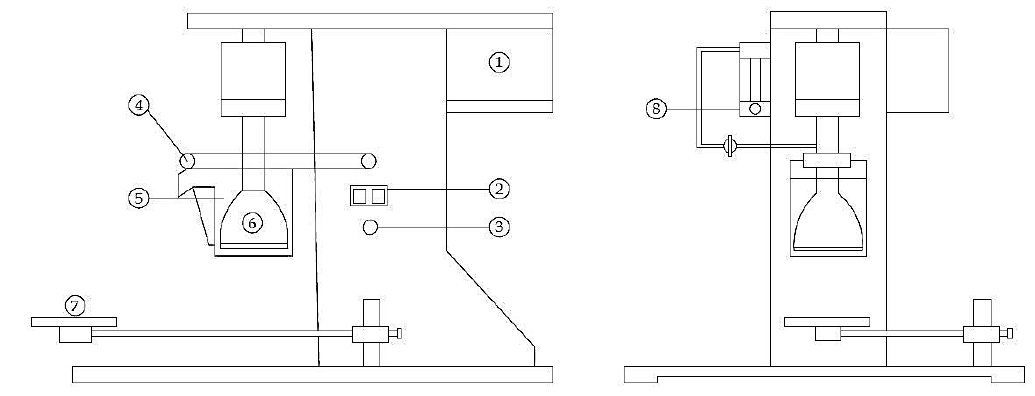
Figure 2. D12 multi-cell flotation cell equipment.